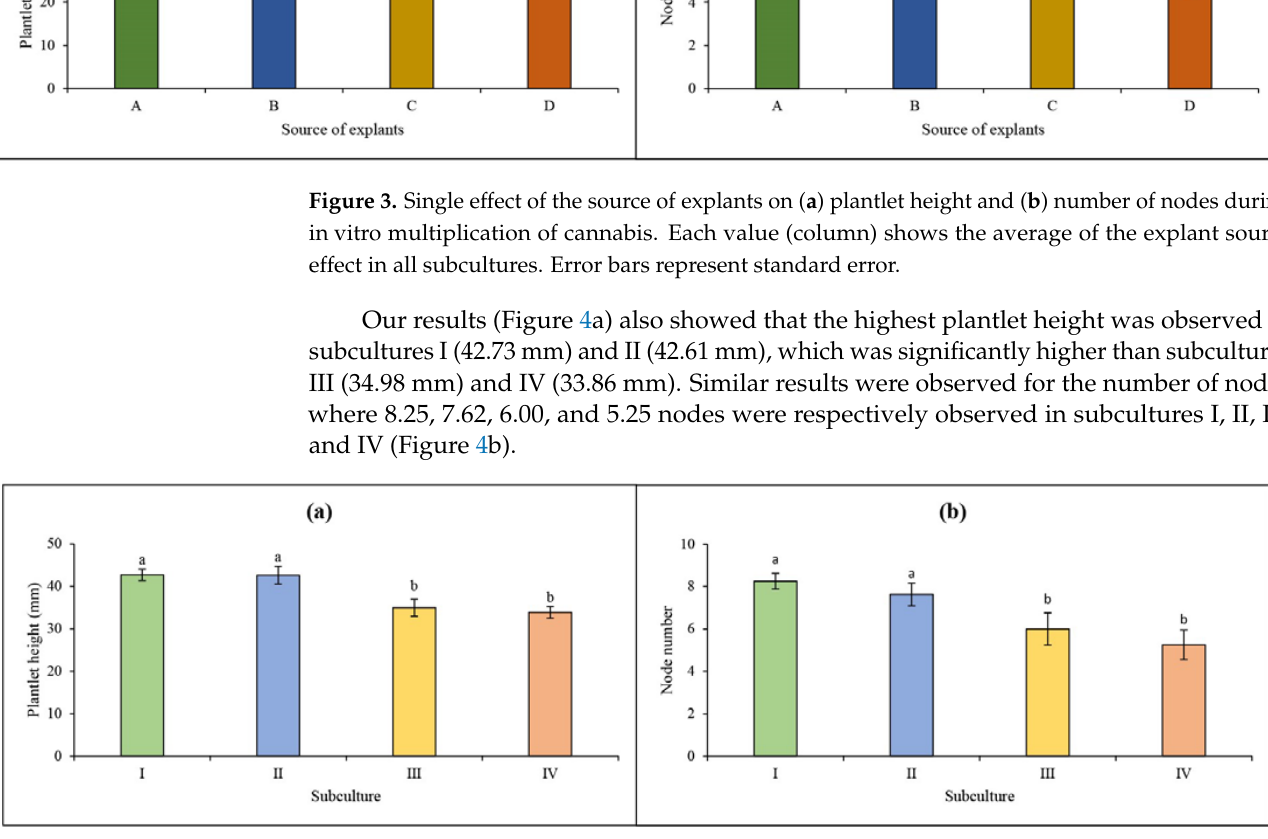
Figure 4. Single effect of the number of subcultures on ( a ) plantlet height and ( b ) number of nodes during in vitro multiplication of cannabis. Each value (column) shows the average of the subculture effect in all explants. Error bars represent standard error.